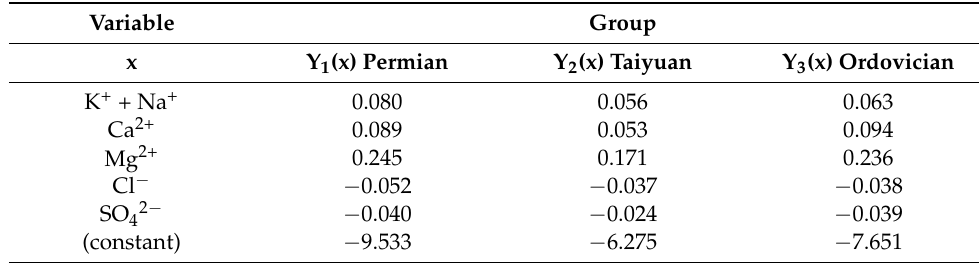
Table 10. Estimation of coefficients (C 0g , C 1g , C 2g , . . . , C pg ) of Bayes multi-class LDA function for conventional ions.